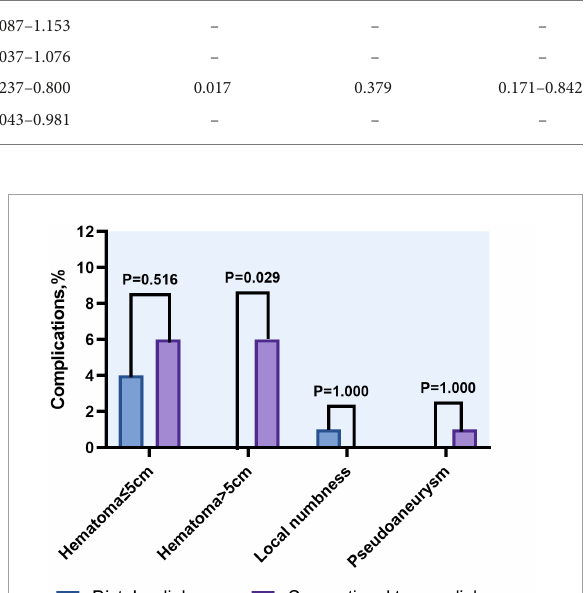
FIGURE6 Access site complications between distal and conventional transradial